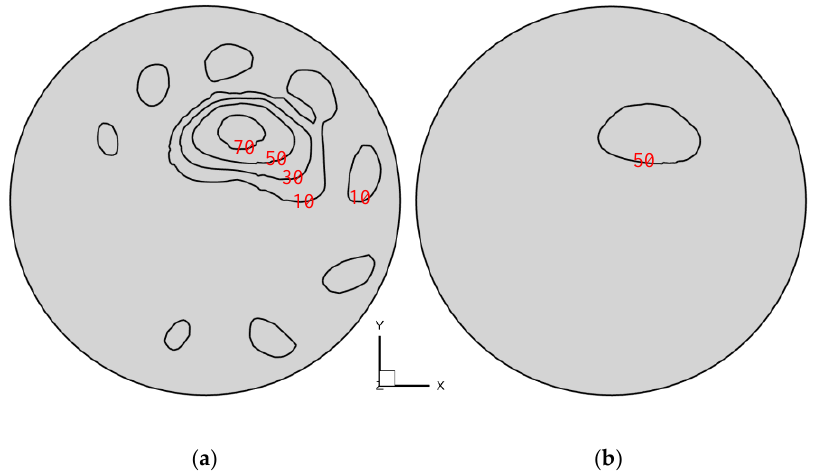
Figure 6. Relative Liutex magnitude M LTX on one section of the draft tube. ( a ) Fine-grained descrip- tion; ( b ) Coarse-grained description. (The numbers represent relative Liutex magnitude).